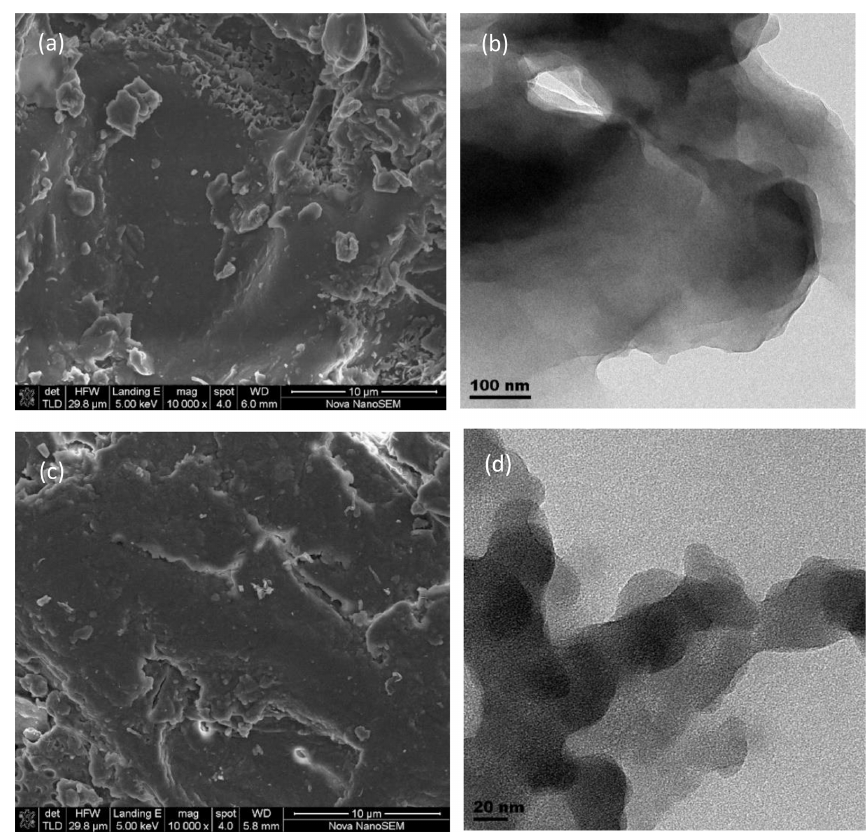
Figure 1. SEM (at × 10000 magnification) and TEM micrographs of Delonix regia leaves (a, b) and pods (c, d)